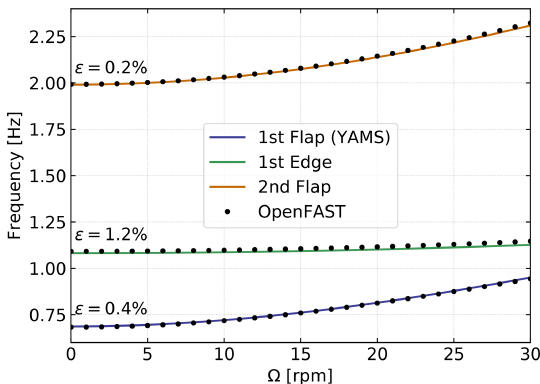
Figure 3. Variation of the natural frequencies of the NREL 5MW turbine blade with rotational speed. Results from YAMS and Open- FAST, with mean relative error, (cid:15) , are reported on the